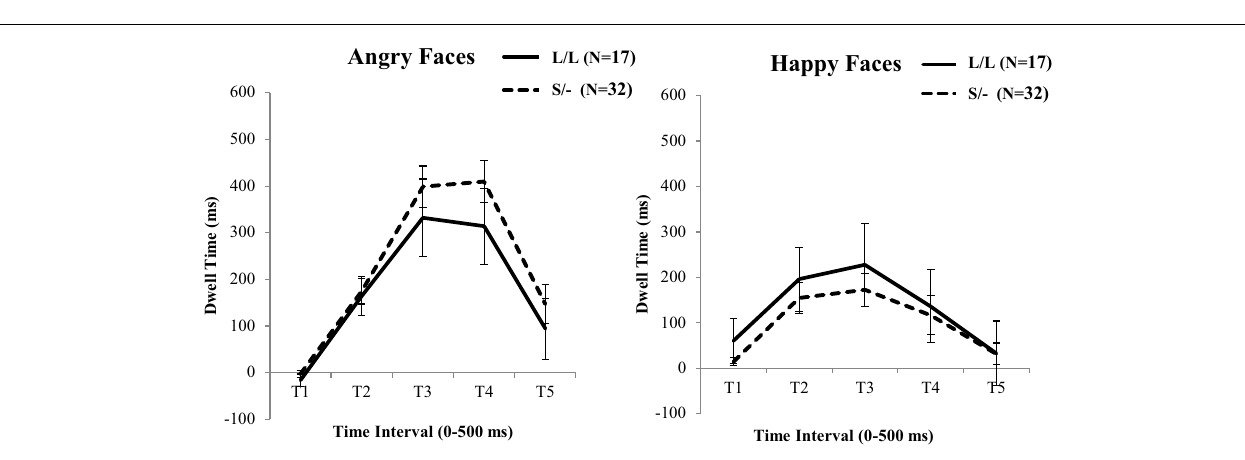
Frontiers in Behavioral Neuroscience |